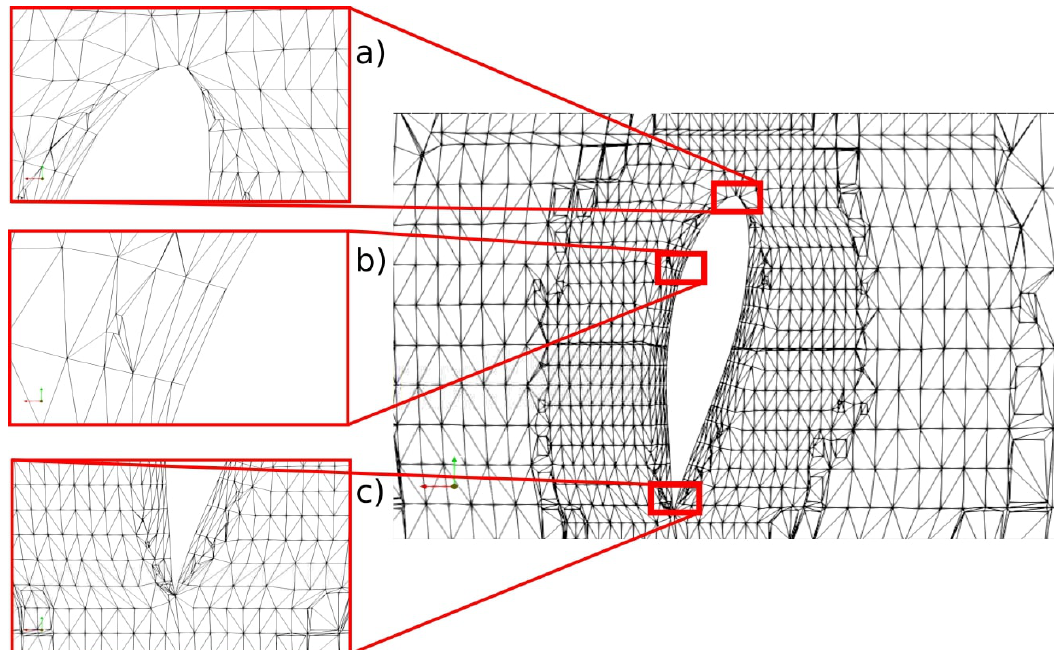
Figure 9. Blade section for a level 5 refinement—the coarsest mesh (#2.1) with a close-up on leading edge ( a ), trailing edge ( c ) and upper surface ( b ). Distorted elements are due to the visualization section.